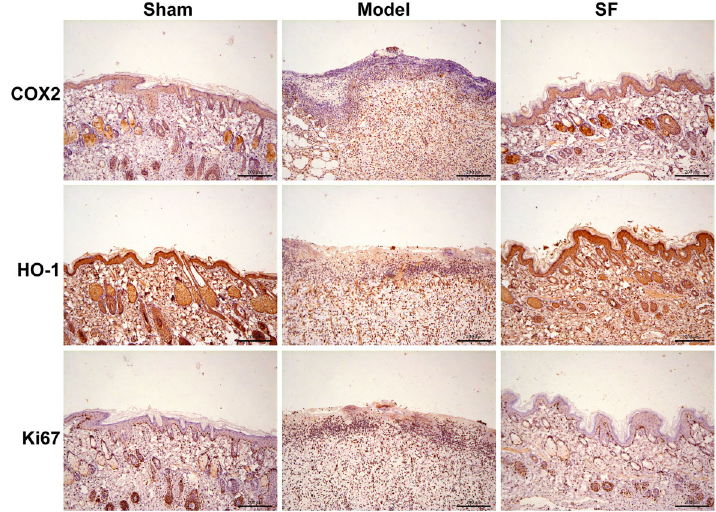
Figure 2. Assessment of the immunohistochemical staining of the fl ap tissue in each group: sham surgery, model group with experimental ischemia-reperfusion injury, and sodium ferulate (SF) treatment group. The SF group presented up-regulation of cyclooxygenase-2 (COX-2), heme oxygenase-1 (HO-1), and Ki67 markers compared with the model group. (n=6). Scale bar, 200 m m.